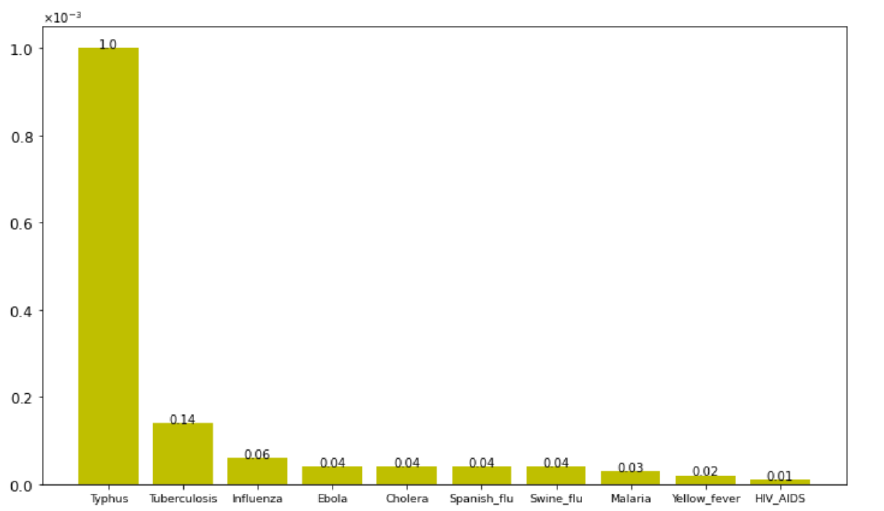
Figure 8. Bar plot of breath